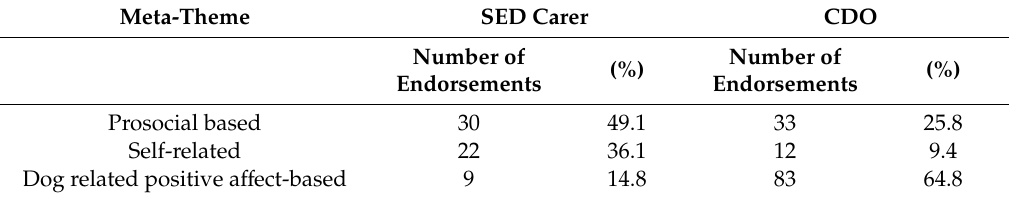
Table 7. Meta Theme Endorsement for Motivations for Becoming a SED Carer Versus